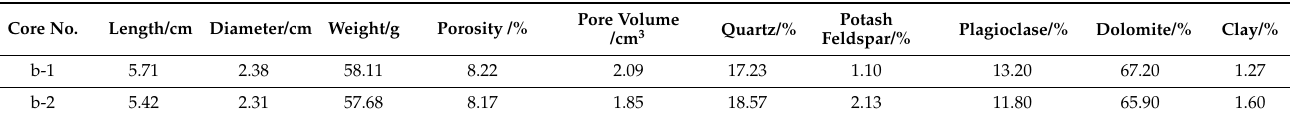
Table 2. Core data for the study of scale-inhibition